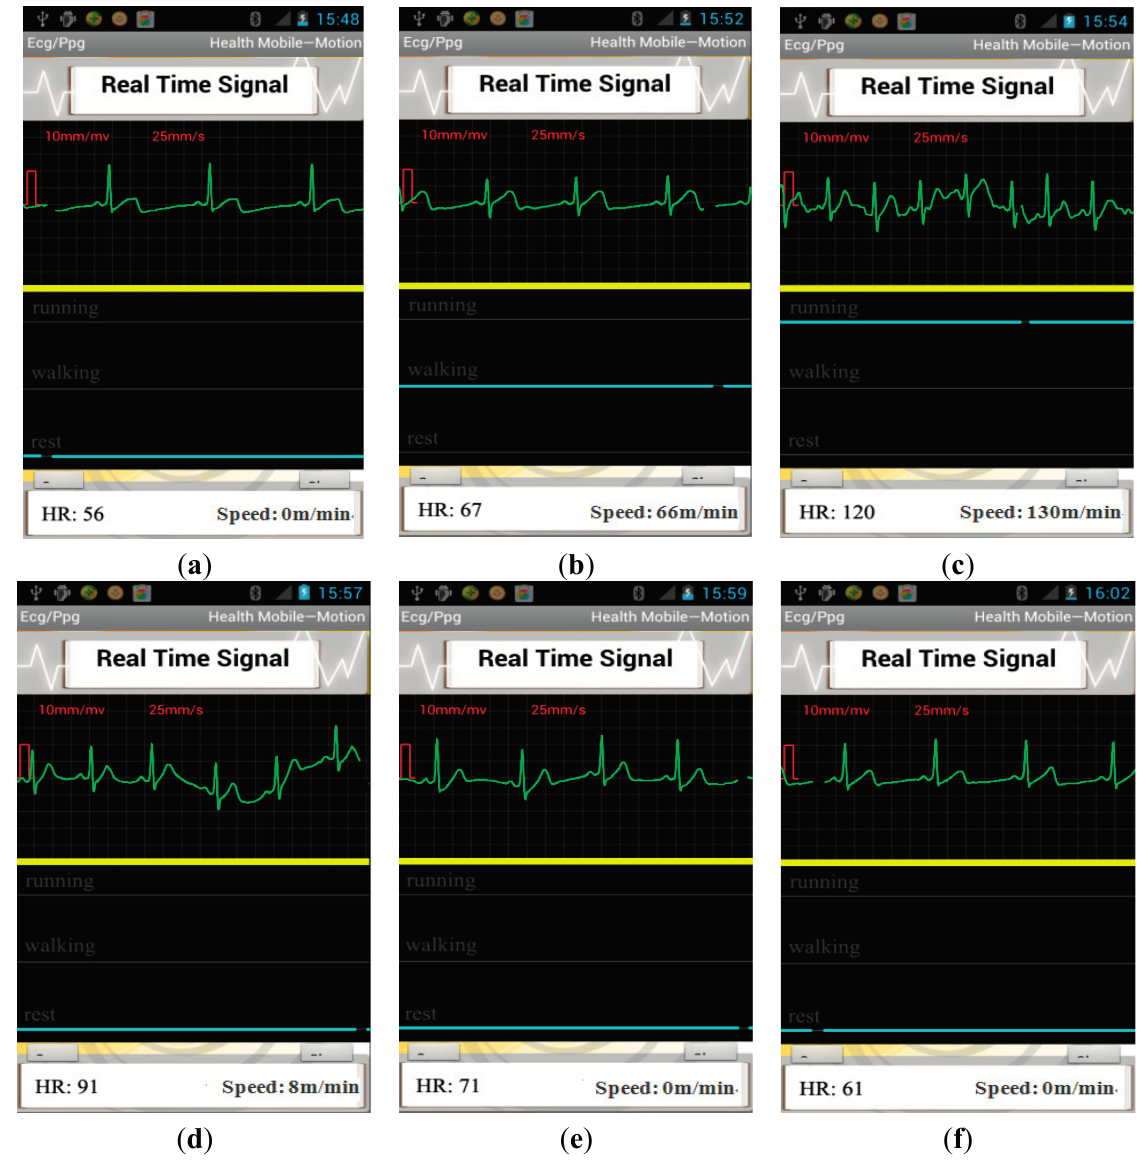
Figure 11. The screenshot of smartphone ( a ) the subject was resting; ( b ) the subject was walking on the treadmill; ( c ) the subject was running on the treadmill; ( d ) the subject rested 30 s after running; ( e ) the subject rested 90 s after running; ( f ) the subject rested 300 s after